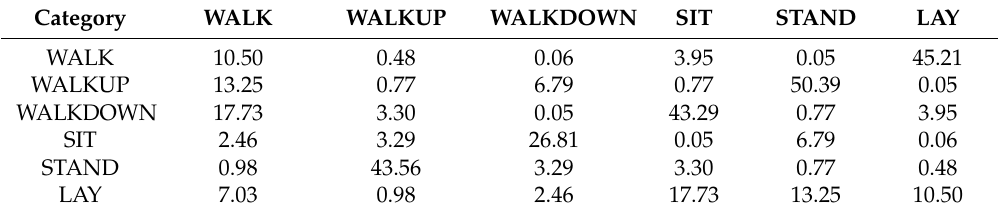
Table 3. The specific inner and outer class divergence of the Original data.